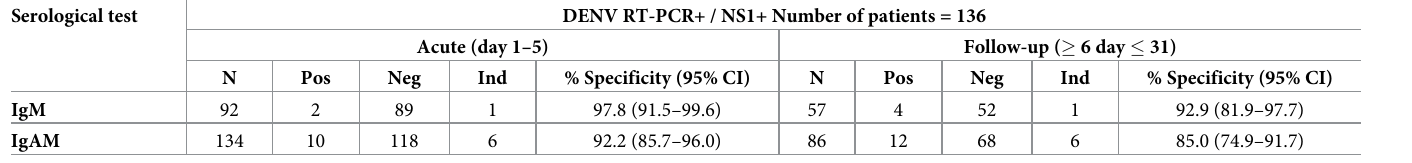
Table 4. Anti-ZIKV IgM and IgAM ELISA specificity. Serological